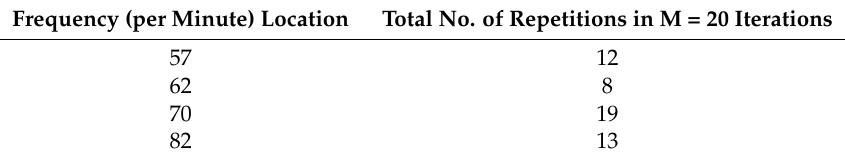
Table 1. The repetition of every peak frequency location.